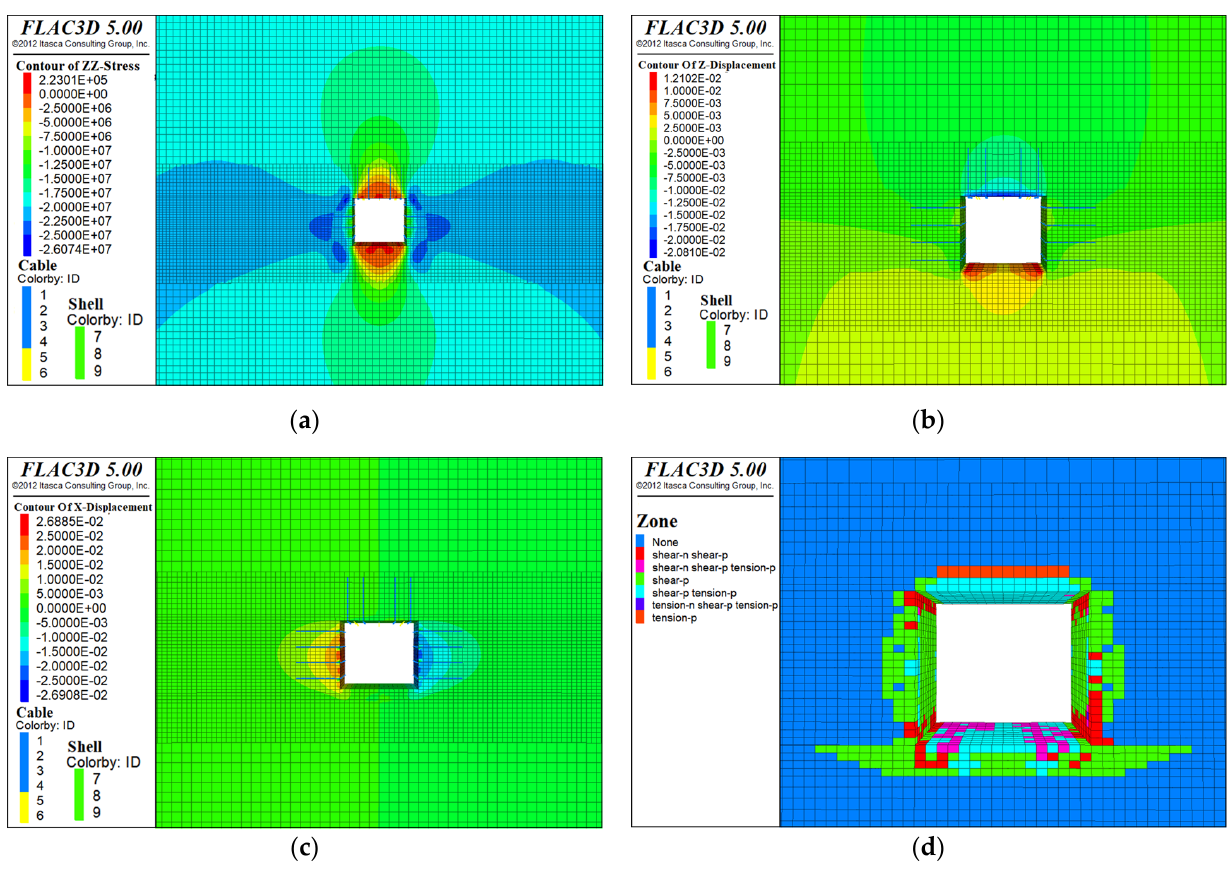
Figure 14. Comparative analysis of supporting effects. ( a ) Full ‐ stress support vertical stress; ( b ) Vertical displacement of full ‐ stress support; ( c ) Horizontal displacement of full ‐ stress support; ( d ) Plastic zone distribution of full ‐ stress support.